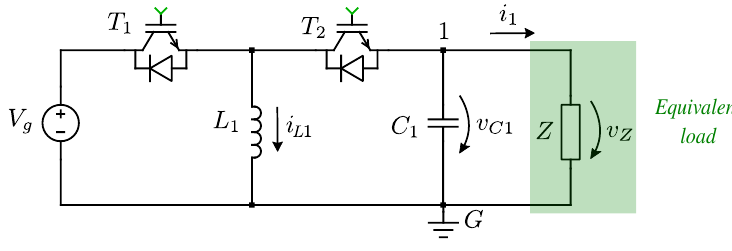
Figure 2. Leg 1 equivalent circuit.